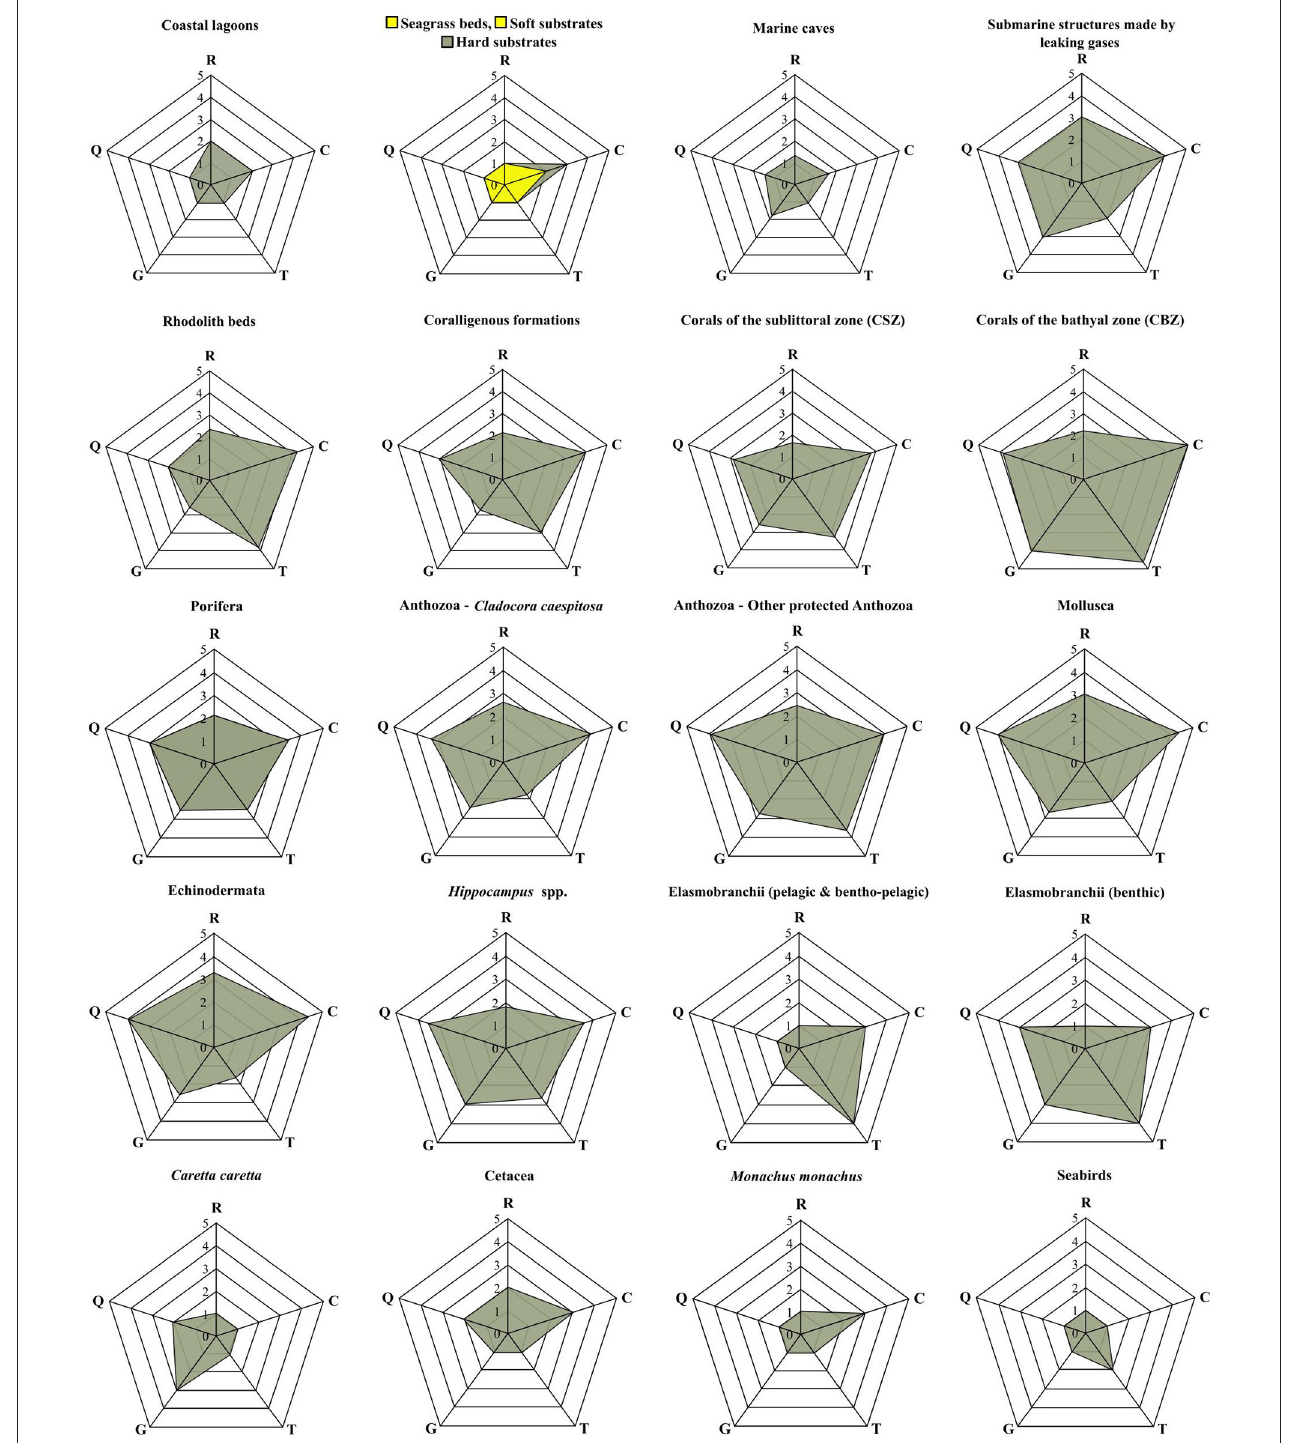
FIGURE 5 | Radar charts illustrating the data evaluation scores per group of ecological features, based on the five data quality indicators of the pedigree matrix. R, Reliability indicator; C, Completeness indicator; T, Temporal relevance indicator; G, Geographical rele vance indicator; Q, Data acquisition methods indicator.